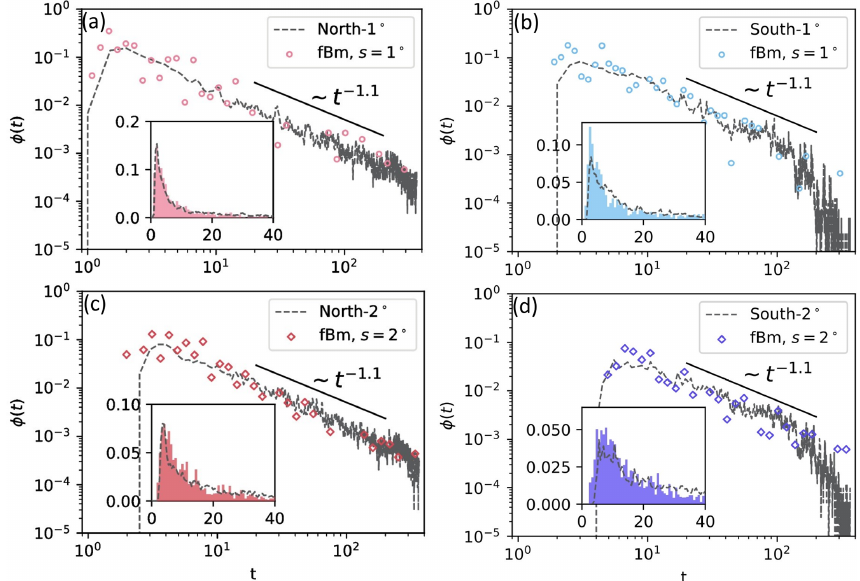
Figure 10. Comparison of the first passage time distribution of the fBm simulation with empirical data for the (a, c) northern subset ( k H = 1000km 2 d − 1 . 8 ) and (b, d) southern subset ( k H = 500km 2 d − 1 . 8 ) of advected parcels. The short solid black lines show the asymptotic behavior t H − 2 with Hurst exponent H = 0 . 9, and the insets show the early behavior of the distribution on a linear scale. The time step (cid:49)t was chosen to be 0 . 0001 for 6600